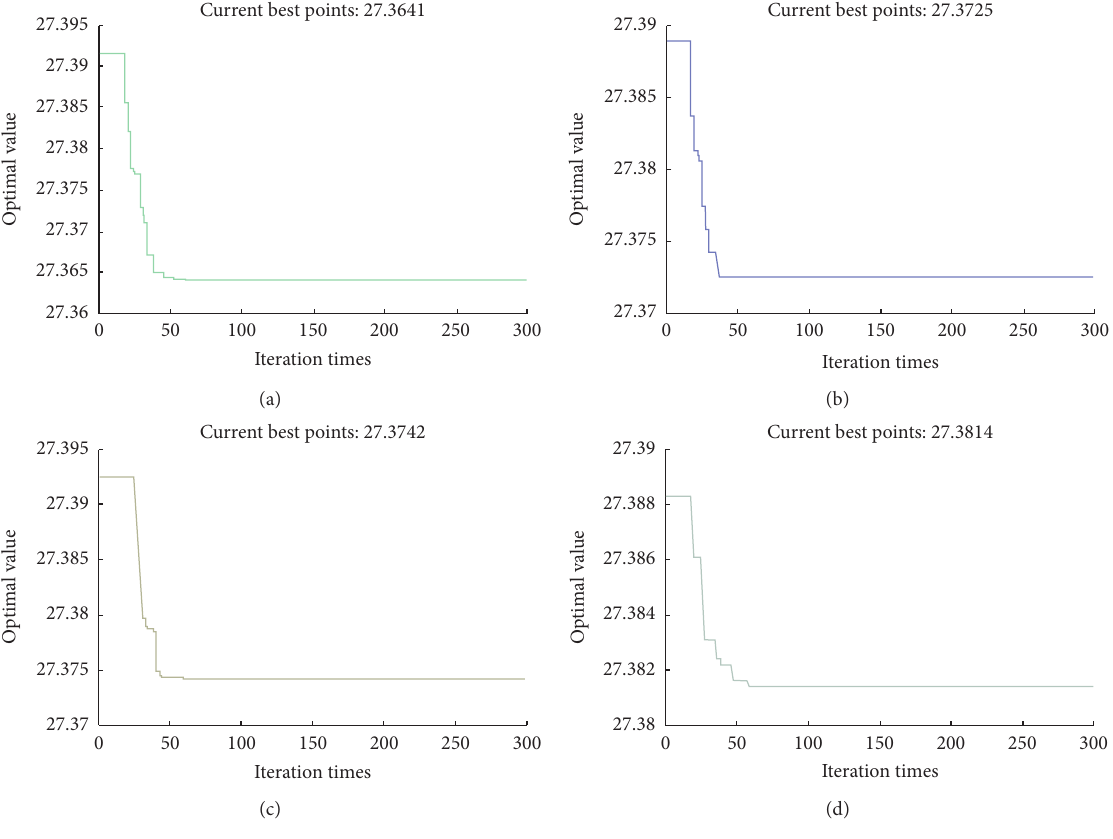
Figure 9: Fitness evolution